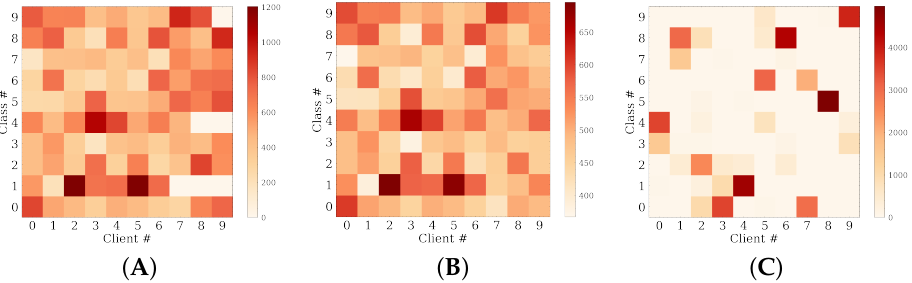
Figure 4. Distribution of the CIFAR-10 dataset across 10 clients according to the Dirichlet distribu- tion. The x-axis shows the index of the client, and the y-axis shows the index of the class (label). ( A – C ) shows the data distribution of α : = 5.0, α : = 1.0, and α : = 0.1, respectively. As parameter α approaches 0, the heterogeneity of class distribution